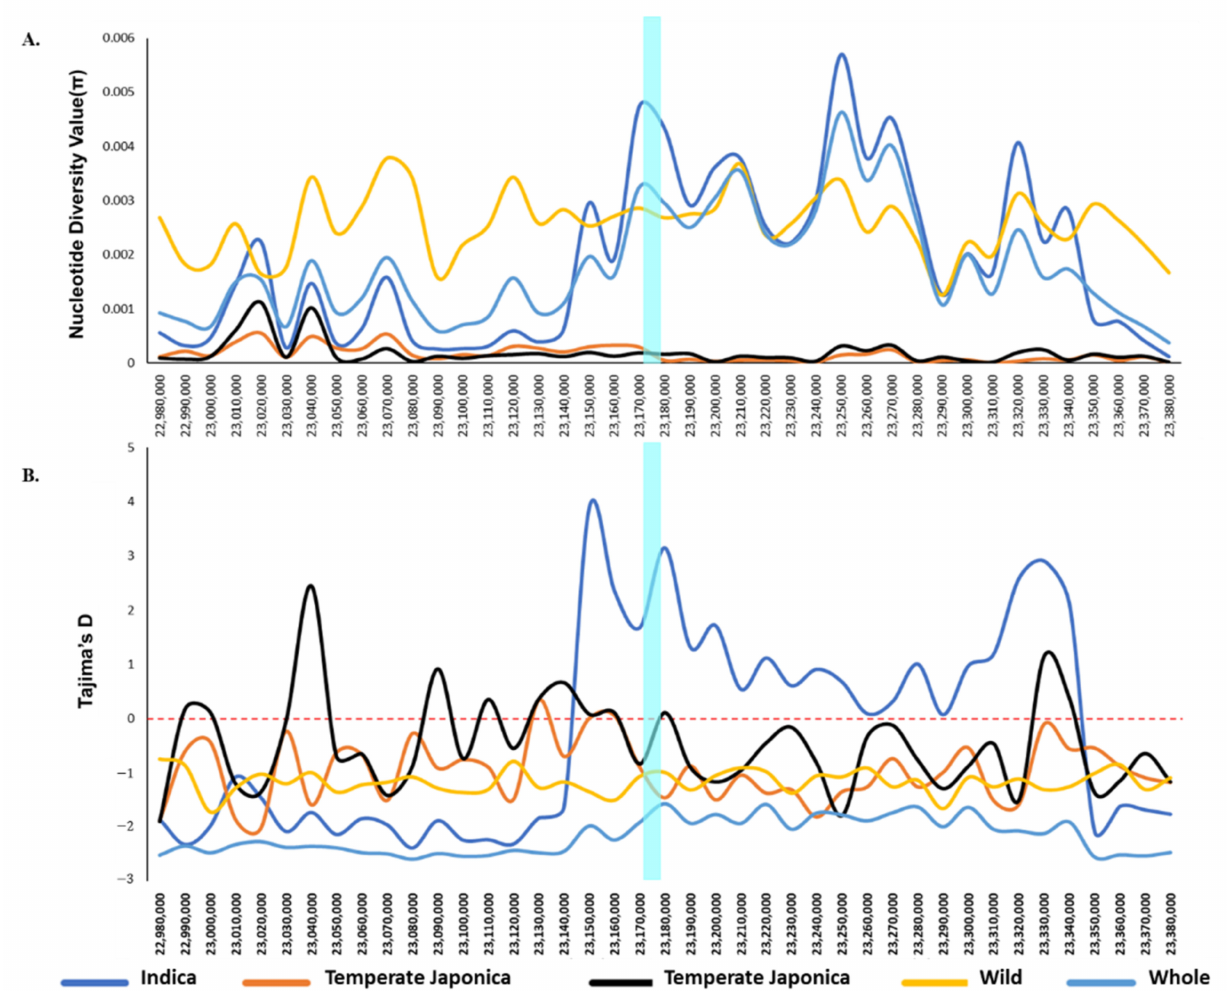
Figure 2. Nucleotide diversity ( π ) values and Tajima’s D values of BADH1 ( Os04g0464200 ) in 475 rice accessions. ( A ) Nucleotide diversity ( π ) indicating different pi ( π ) values at segregating sites of different classified groups deter- mined with a 10 kb sliding window within the BADH1 region ( B ) Tajima’s D values indicating different variations among the classified groups identified by a 10 kb sliding window within the BADH1 region. Cyan color indicates the BADH1 gene region; each colored line represents different rice groups in terms of